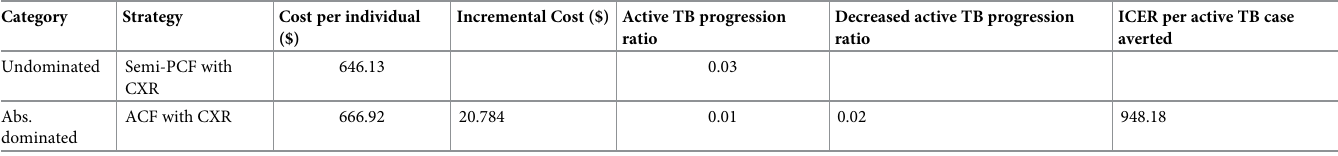
Table 5. Cost-effectiveness rankings report of the model.